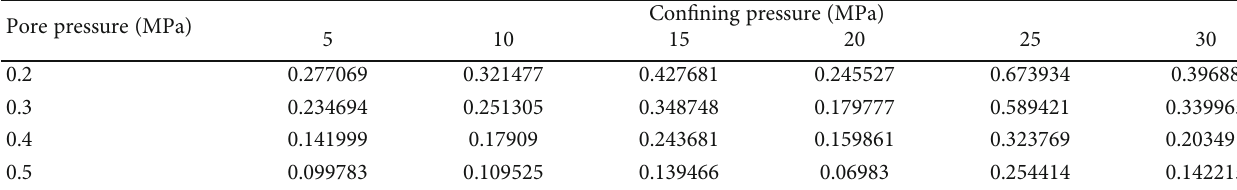
Table 4: Contribution rates of the gas slippage e ff ects (100 °